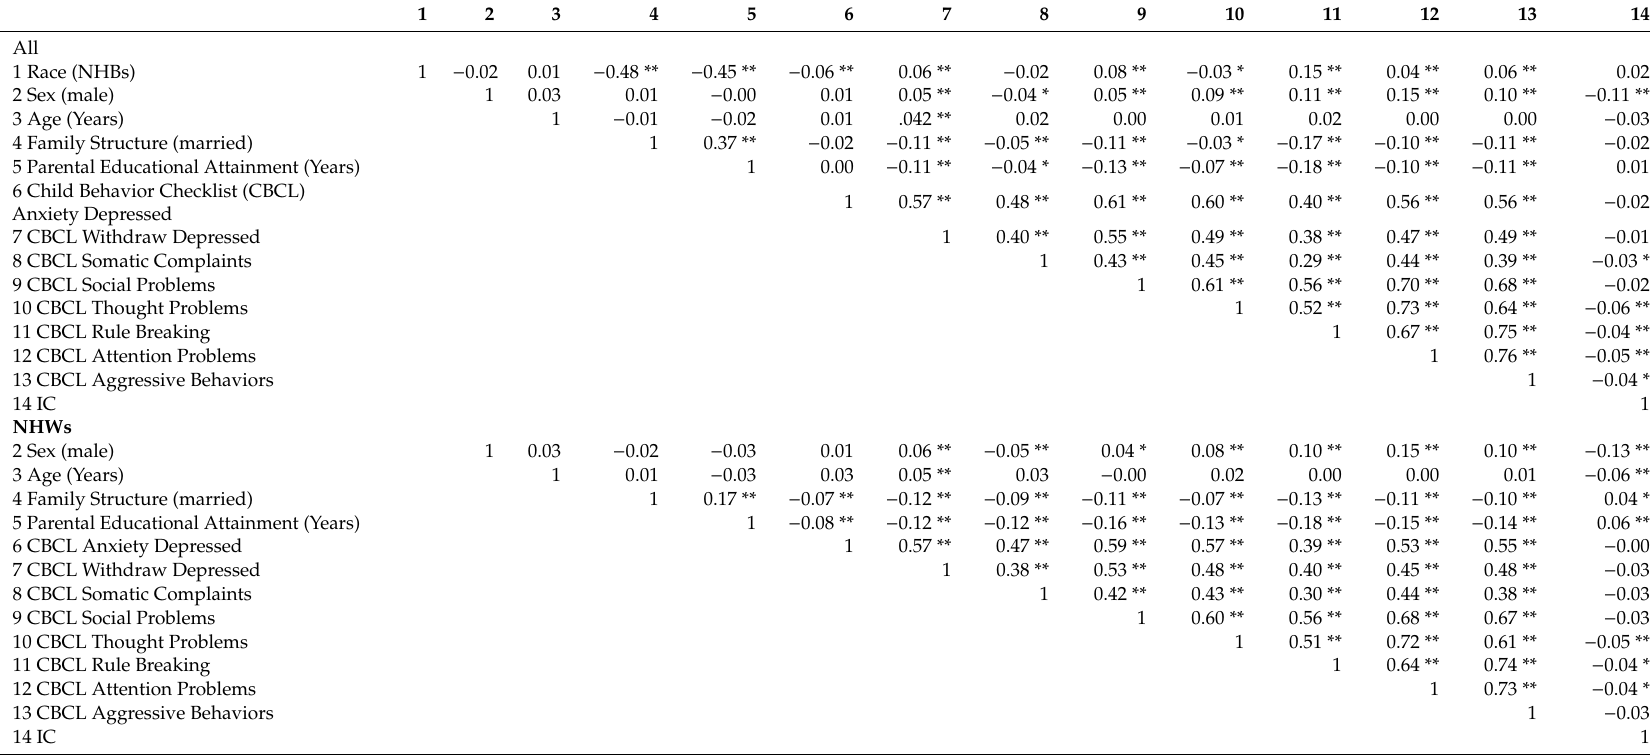
Table 2. Correlations between study variables ( n =